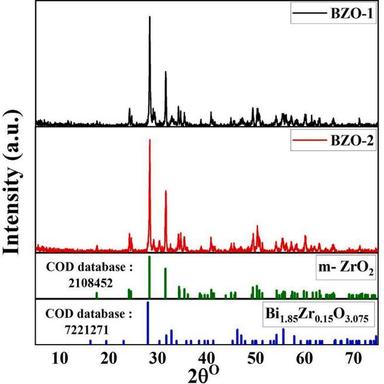
XRD pattern of two prepared BZO composite samples.